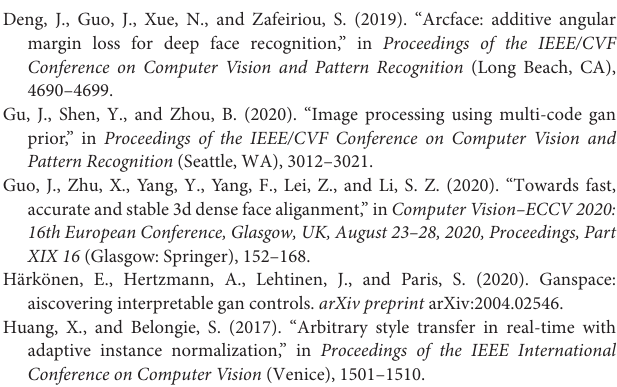
to map a wild face to a most similar face in the StyleGAN face domain, which is a more natural result with better image